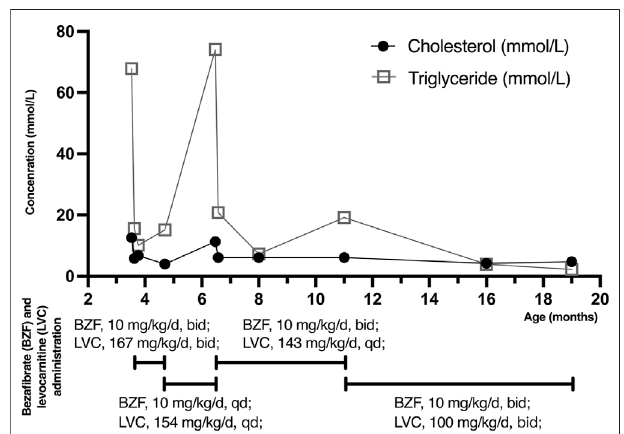
FIGURE 2 | Cholesterol (CHOL) and triglyceride (TG) levels with beza fi brate (BZF) and levocarnitine (LVC) administration. The patient was admitted to hospital with high levels of CHOL (12.58 mmol/L) and TG (67.84 mmol/L) at the age of 3 months and 16 days. Three days later, her CHOL and TG levels plummeted due to beza fi brate and levocarnitine administration. The levels kept decreasing until she was discharged. Her parents reduced the dose without professional medical advice, resulting in a severe relapse (a sharp increased TG level at the age of 6 months and 14 days). The dose of medications was then adjusted and CHOL and TG levels of the patient fi nally declined to normal and almost normal. (TG: 1 mol/L = 88.5